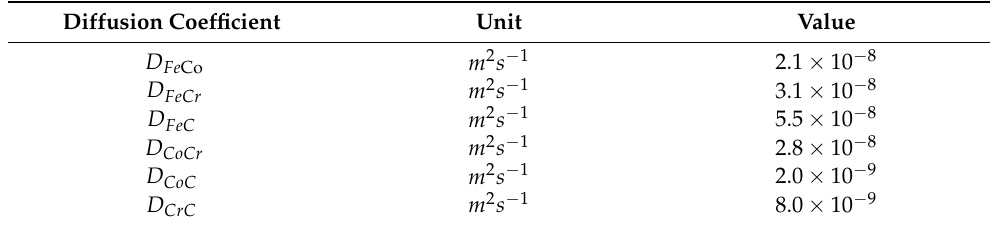
Table 3. Binary diffusion coefficients used for the calculation of multi-component diffusion coefficients [24]. Diffusion